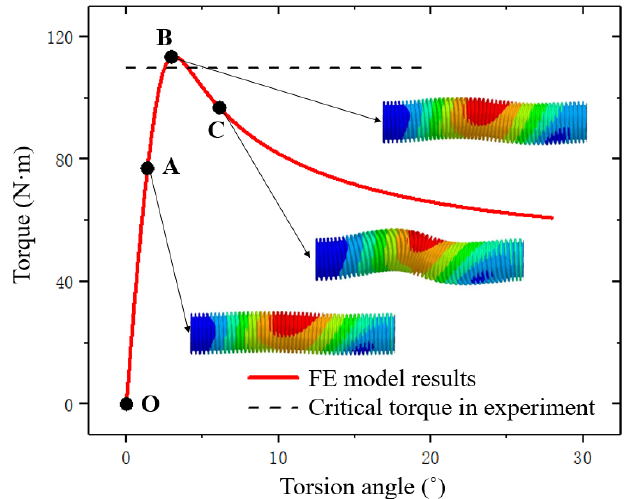
Figure 19. The process of the post-buckling of the toroid bellows.